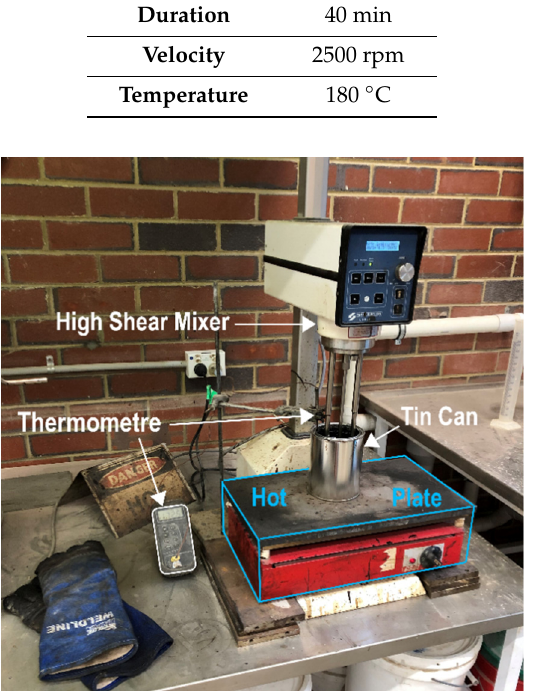
Figure 3. Bitumen Mixing Apparatus (Civil Engineering Laboratory, Curtin University, Image Courtesy: Benjamin Piromanski).